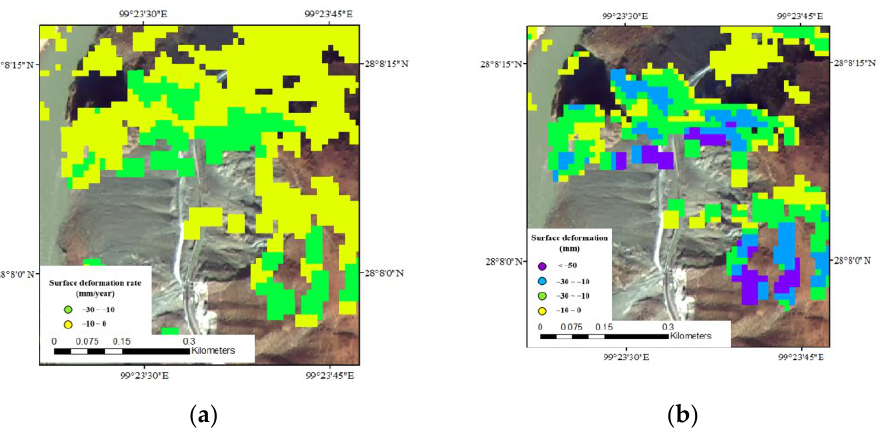
Figure 7. The surface deformation extraction result map of the study area (LOS direction). ( a ) The surface subsidence rate map; ( b ) The surface cumulative deformation map.